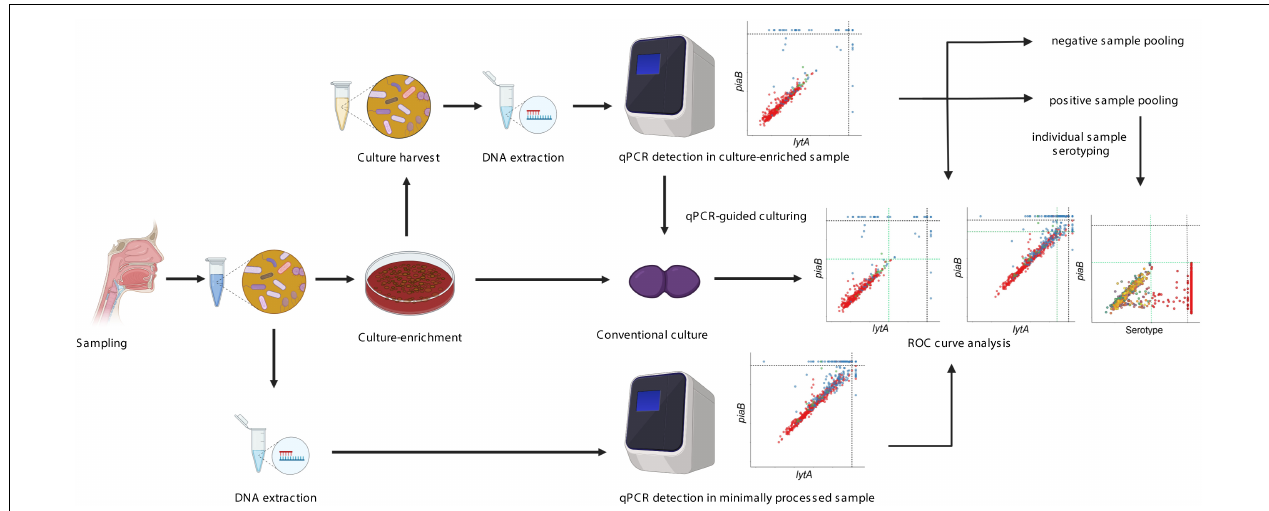
FIGURE 1 | Overview of the “two-to-tango” protocol. A respiratory sample is collected from a study participant and 200 µ l sample is split into two parts. One part is used directly for DNA extraction while another part is plated on selective culture media for culture-enrichment. Detection of S. pneumoniae presence by conventional culture is conducted on the culture-enriched sample. Once completed, all microbial growth is harvested in a broth supplemented with glycerol. DNA extraction is performed on the raw sample and culture harvest. Molecular detection of S. pneumoniae is conducted with piaB and lytA qPCRs and culture-negative but qPCR positive samples are revisited for qPCR-guided culturing. Receiver operating characteristic curve analysis is performed to increase the specificity of qPCR detection for presence of live pneumococcus. A sample pooling strategy is conducted, samples negative for pneumococcus are pooled by 10 and samples positive for pneumococcus are pooled by five. Serotyping by qPCR is conducted on pooled samples. If the pool is classified as positive all samples are tested individually for a given serotype. Negative pools are used to evaluate the specificity of serotype-specific qPCR assays. The figure was made using Biorender.com.